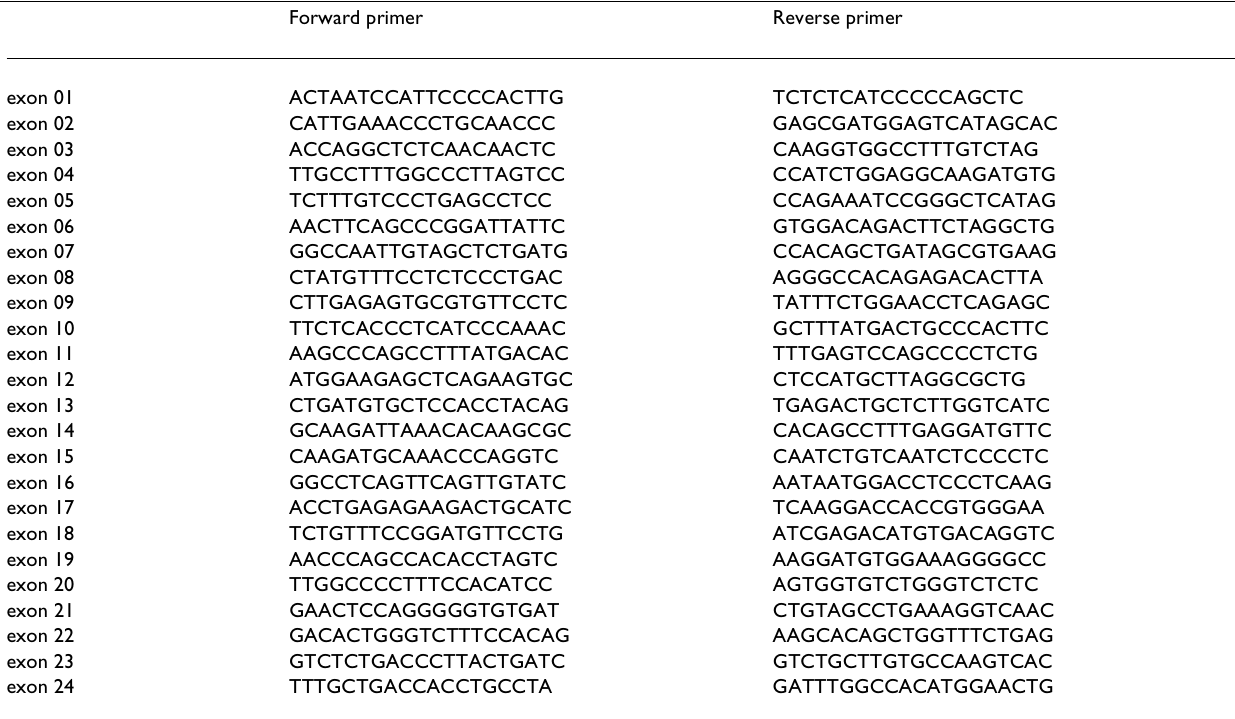
Table 1: Primer list for SNP analysis of the IHRP